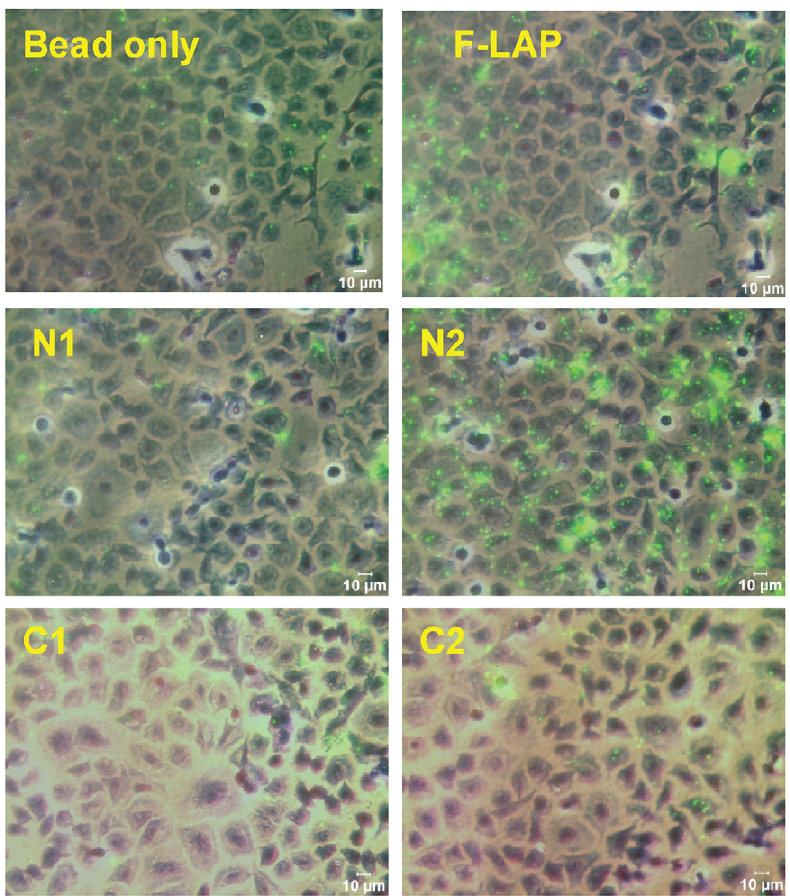
Figure 4. Representative photomicrographs from Fig 3, showing fluosphere binding to HCT-8 cell monolayers. Cell monolayers were counter stained with Giemsa stain before examining under Leica microscope (400X magnification). Cell monolayers exposed to N2 and F-LAP-coated fluospheres showed higher numbers of fluospheres compared to other treatments.